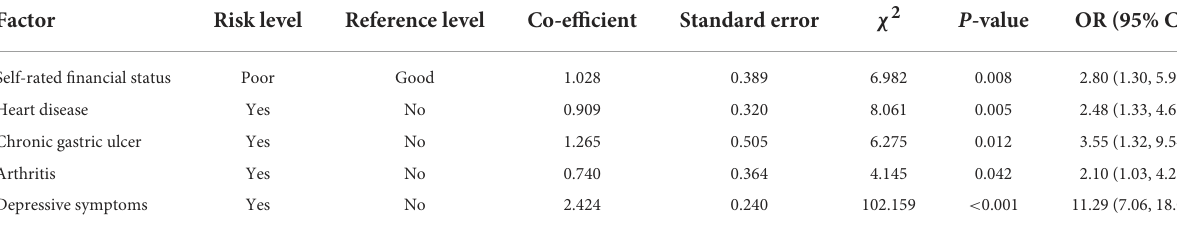
TABLE 2 Correlates of suicidal ideation in older primary care